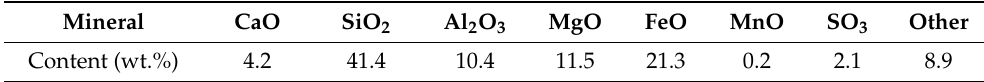
Table 1. Chemical components of tailings.